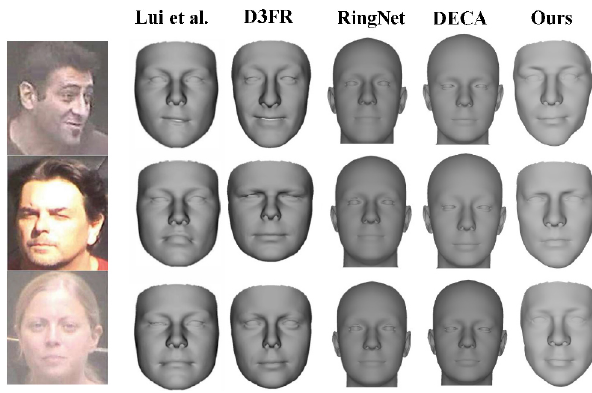
Fig. 7 Comparison with Liu et al. [11], RingNet [9], D3FR[34], and DECA [41] on three MICC [71] subjects. Our reconstruction results capture more face details.